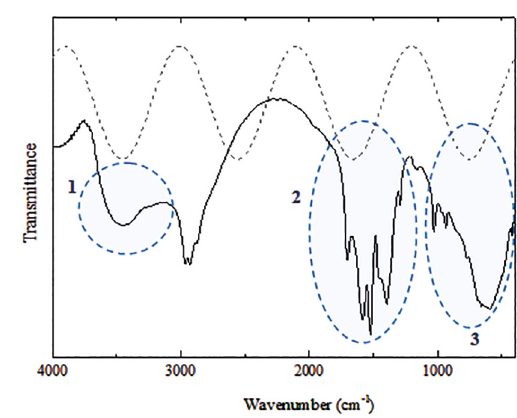
Figure 3. Infrared transmittance spectrum for the sample deposited with Δ = 15% (solid line) and sinusoidal simulated curve for an optical interference process (hatched line). The circles highlight the parts of the spectrum in which the optical interference contributes to the intensities of the bands of the